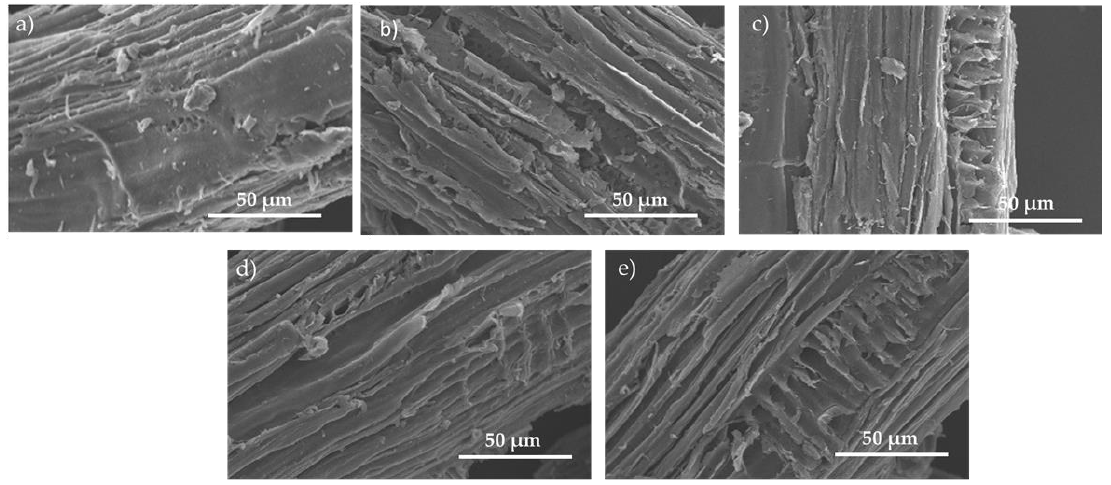
Magnification at 700×. Figure 6. Cont